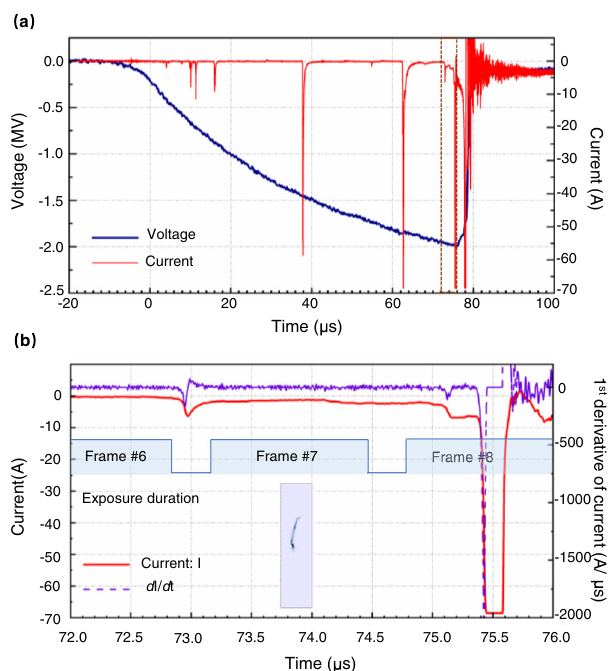
Fig. 6 Discharge current associated with the negative leader step. Panel a is the discharge current of the negative leader step, synchronized with the applied impulse voltage waveform. Panel b shows the detail of the current in the brown box marked in the above panel. The current is synchronized with the exposure strobe of the high-speed camera. The fi rst derivative of the current was calculated, shown in the fi gure to indicate the variation of the current rise